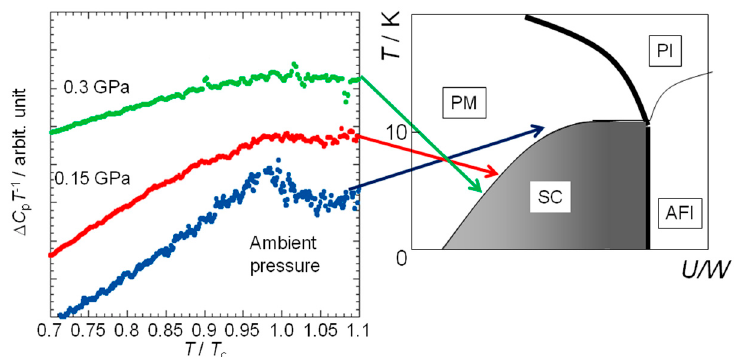
Figure 7. Systematic changes in the peak shape of κ -(BEDT-TTF) 2 Cu(NCS) 2 as the pressure increases up to 0.30 GPa. (See details in Ref. [32].) Temperature in the horizontal axis is scaled by T c to qualitatively evaluate the sharpness of the thermal anomaly. Correspondence of the data in each pressure is shown in the schematic phase diagram of the dimer-Mott